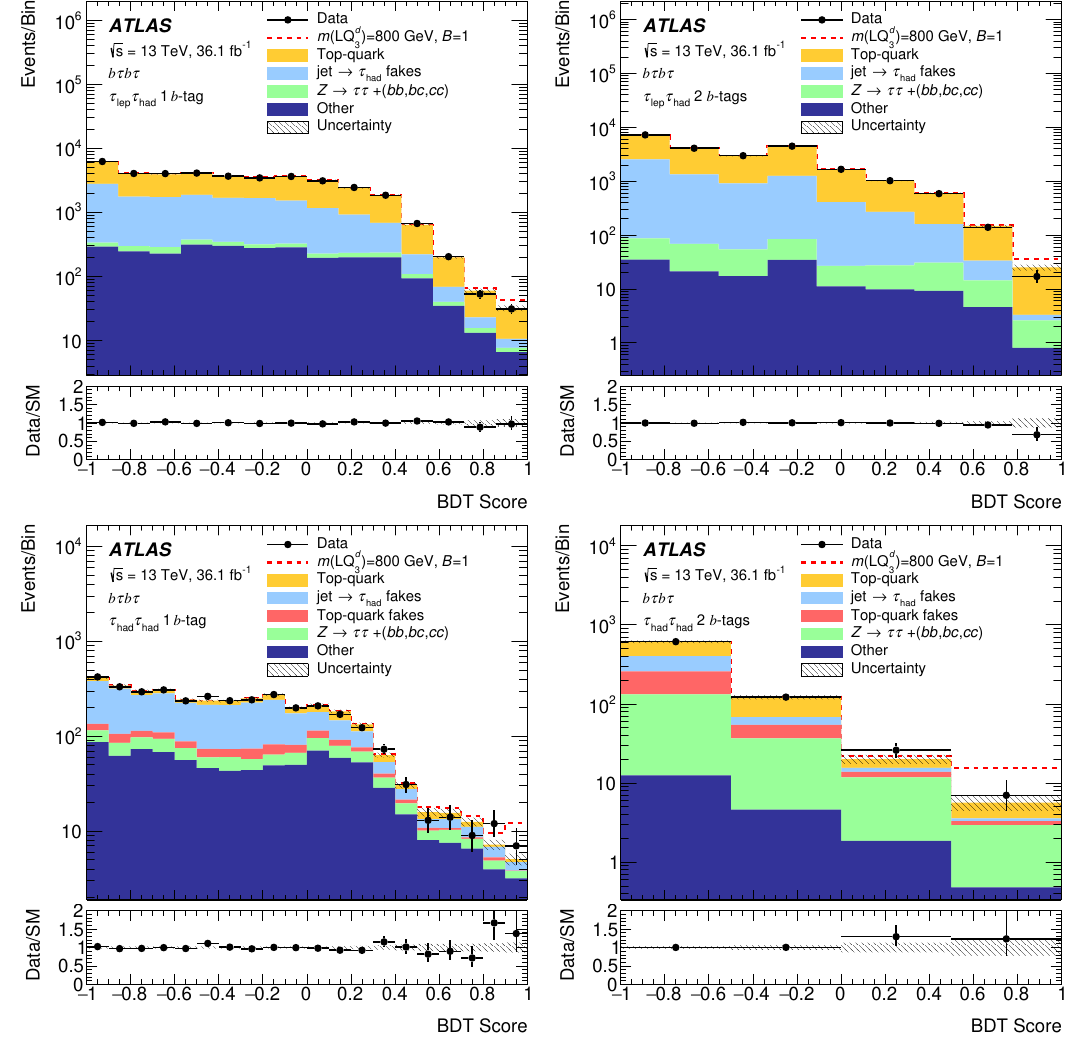
Figure 7 . BDT score distributions for (cid:28) ‘ (cid:28) had (top) and (cid:28) had (cid:28) had (bottom) channels in the 1-tag (left) and 2-tag (right) regions after performing the combined channel (cid:12)t. The stacked histograms show the various SM background contributions, which are normalized to the expected cross-section. The hatched band indicates the total statistical and systematic uncertainty in the SM background. The error bars on the black data points represent the statistical uncertainty in the data yields. The dashed histogram shows the expected additional yields from a leptoquark signal model for a down-type leptoquark sample with a mass of 800 GeV ( B = 1) added on top of the SM prediction. The ratio of the data to the sum of the backgrounds is shown in the lower panel.